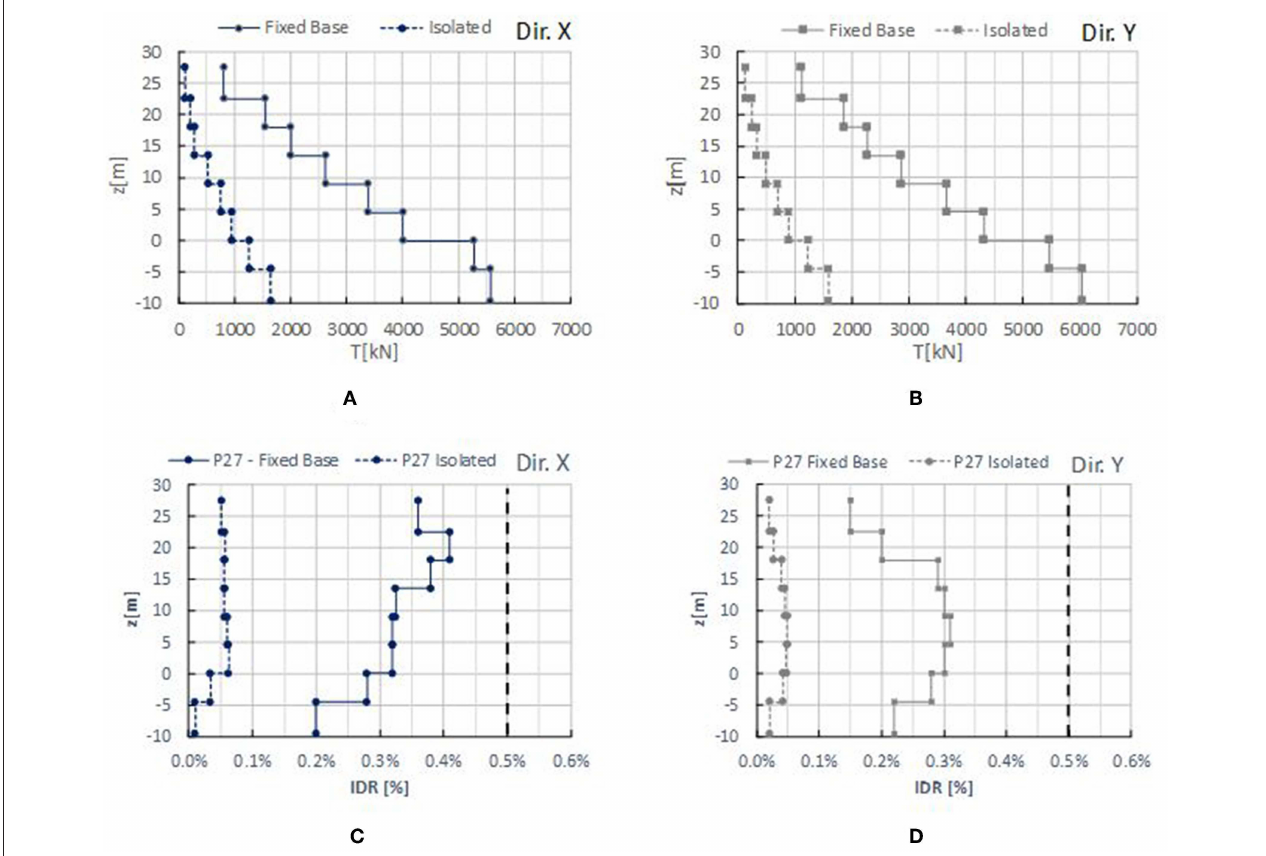
FIGURE 12 | Fixed-base vs. base-isolated model. Comparison over the height of floor shears (at Life Safety Limit State) for the X-direction (A) and Y-direction (B) and of Drift Ratios (at Damage Limit State) for Column 27 for the X-direction (C) and Y-direction (D)